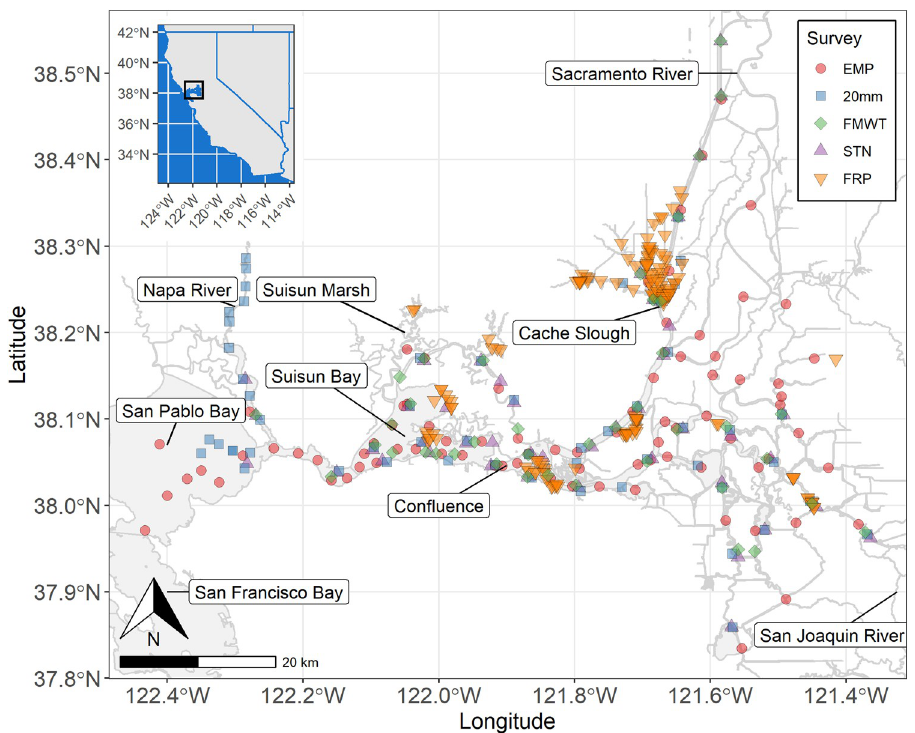
Fig 1. Map of active and historical sampling locations. Only fixed stations are shown. The unfixed EMP EZ station locations move with the estuarine salinity gradient and are provided in the stations_EMP_EZ table. The Sacramento San Joaquin Delta is the region East of the Confluence. State boundaries were reproduced from the United States Census Bureau.